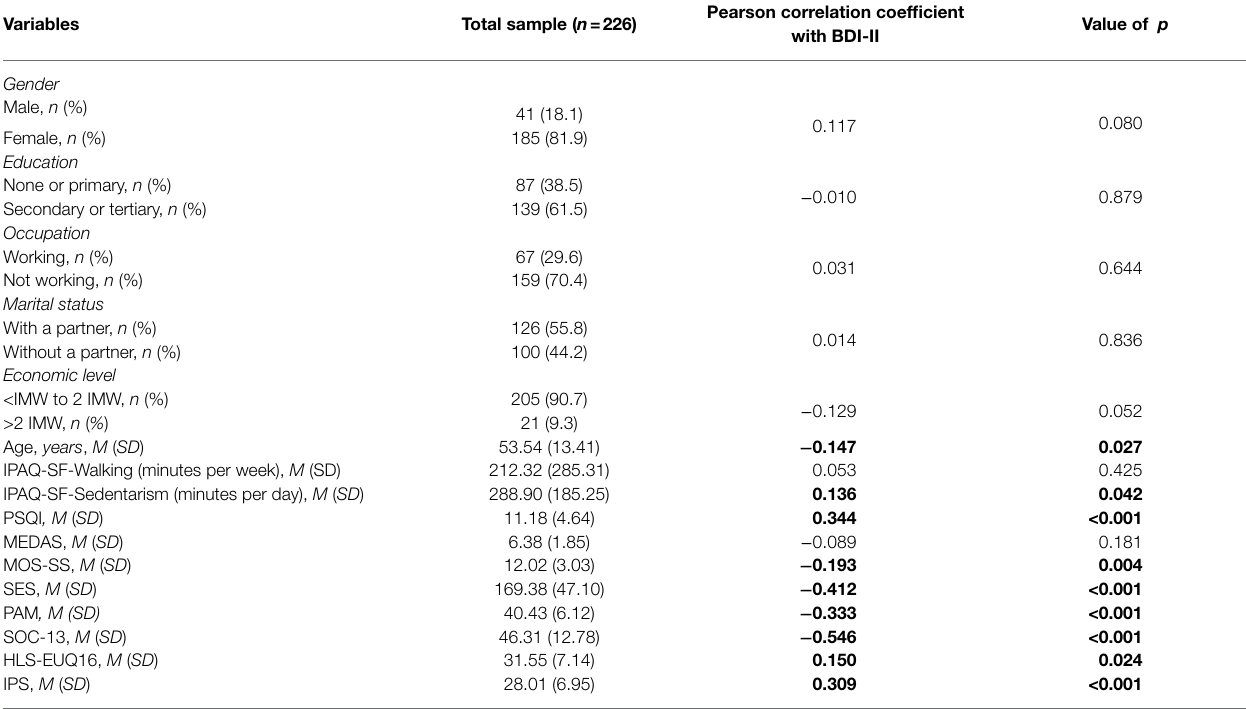
TABLE 1 | Demographic characteristics, lifestyle variables, and personal factors of the sample.